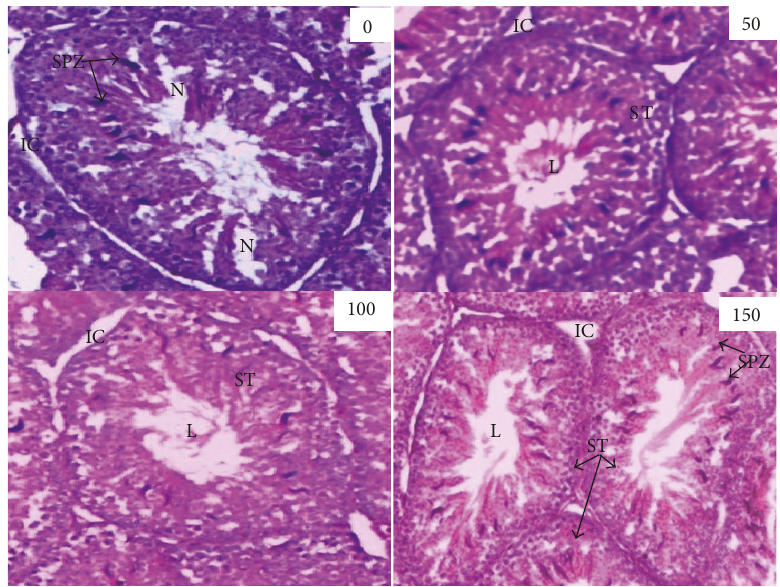
Figure 1: Histological structure of Japanese quail testes as affected by ginger roots essential oil (400x). 0 (control); 50, 100, and 150: doses of ginger roots essential oil ( 𝜇 l/kg body weight). SPZ: spermatozoa; ST: seminiferous tubules; IC: interstitial cells; L: lumen; and N: necrosis. Table 3: Effects of graded level of ginger roots essential oil on growth characteristics and relative organ weightsof male Japanese quail. Parameters Growth